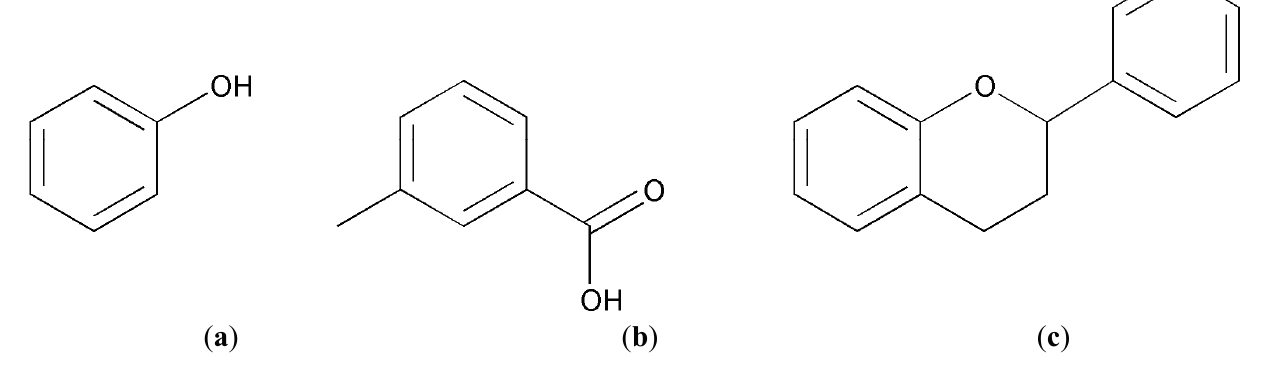
Figure 2. Structures of common phenolic compounds ( a ) phenol; ( b ) phenolic acid; ( c )